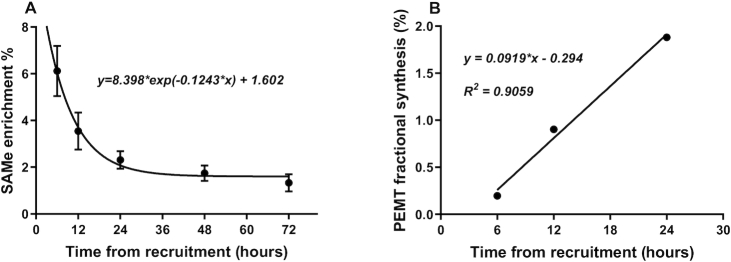
Fractional rate of plasma PC synthesis by the PEMT pathway. (A) The enrichment of hepatic SAMe was determined by MIDA calculation based on the relative incorporations of the methyl-D3 and methyl-D6 labels into PC (mean ± SEM, n = 27). (B) Rate of fractional synthesis by the PEMT pathway after correcting enrichment of methyl-D3-PC for enrichment of SAMe at each time point (% total PC). MIDA, mass isotopomer distribution analysis; PC, phosphatidylcholine; PEMT, phosphatidylethanolamine N-methyltransferase; SAMe, S-adenosylmethionine.